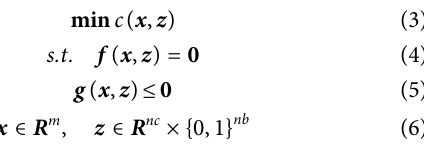
Frontiers in Energy Research |